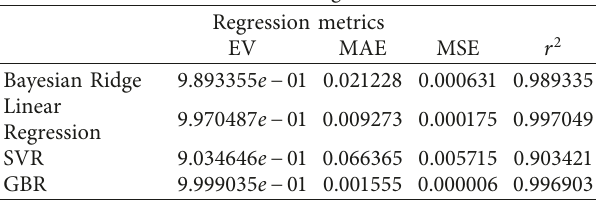
Table 9: Fitting effect.